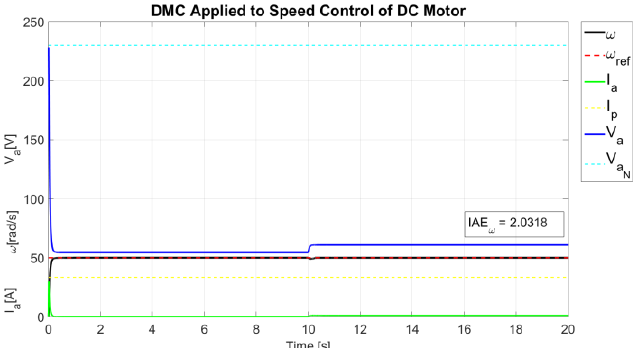
Fig. 9 presenting operation of DC motor controlled by DMC tune by hybrid optimization method details